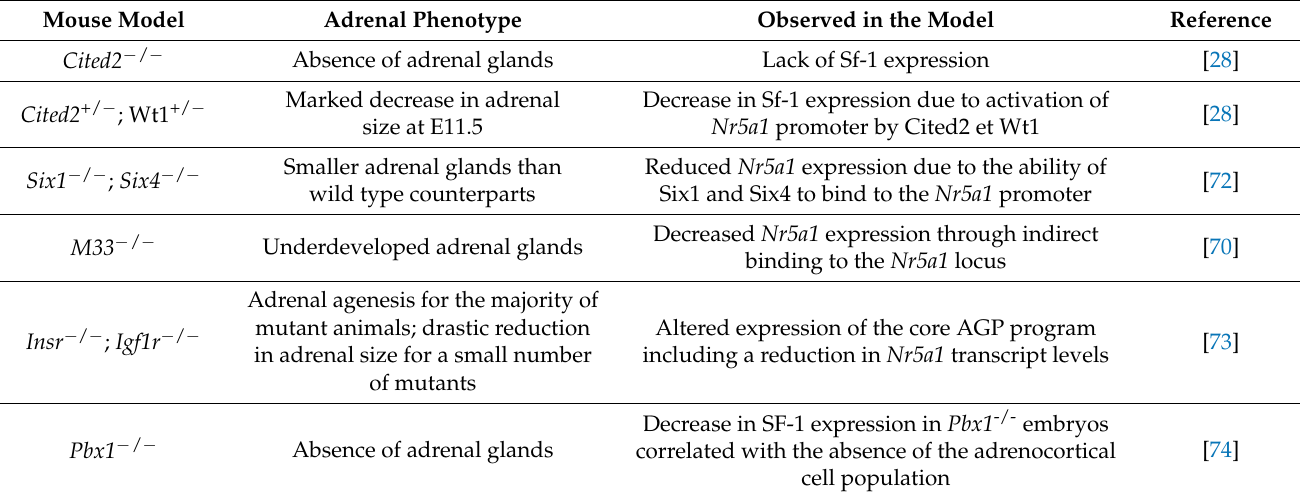
Table 1. Mouse models with altered SF-1